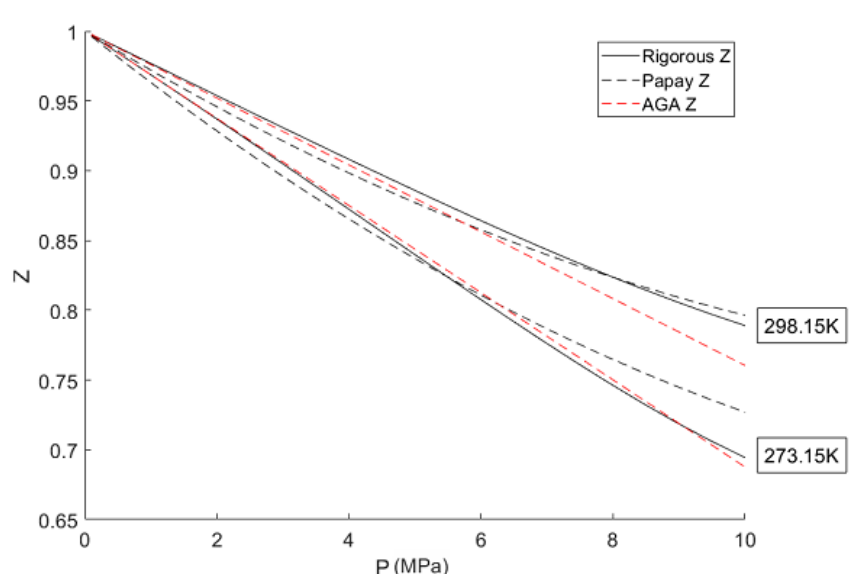
Figure 1. Comparison of the rigorously calculated gas compressibility factor with the American Gas Association and Papay empirical models for natural gas with a composition of: 85% methane, 14% ethane, and 1%